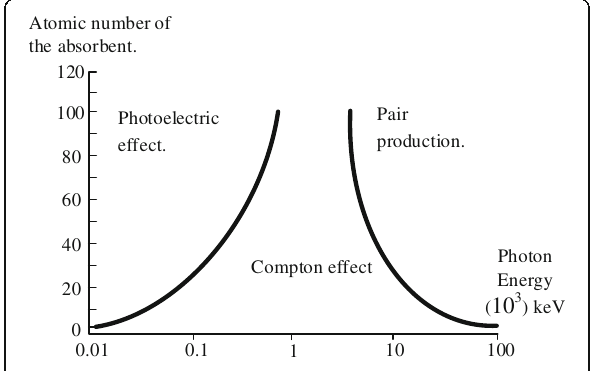
Fig. 1 Main interactions between photons and the matter (adapted from Cherry Jr. (1993))